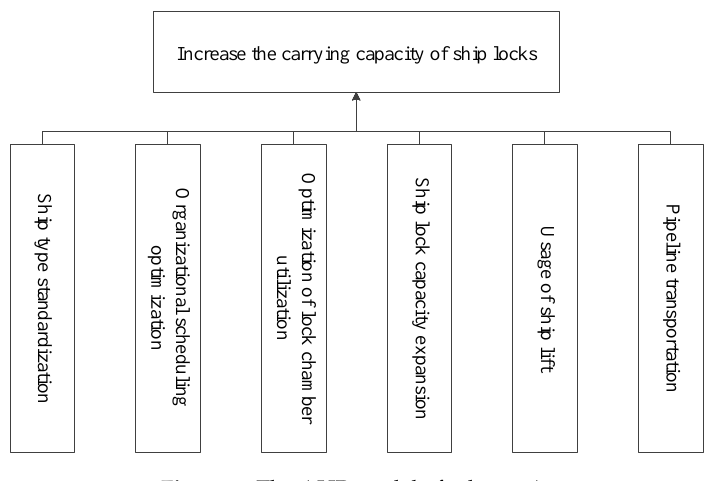
Figure 5. The AHP model of scheme A.